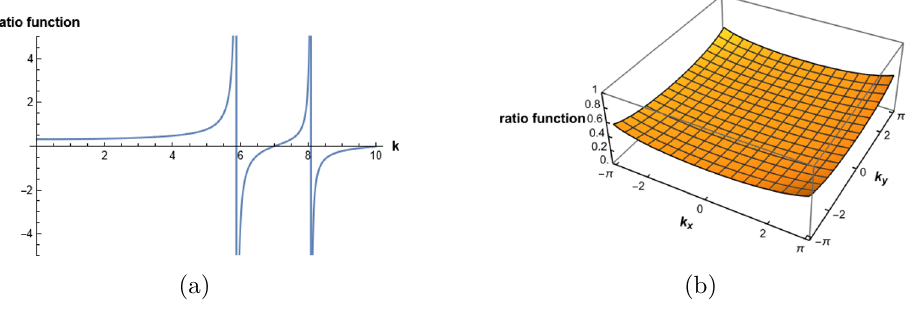
Figure 6. The plot of the ratio